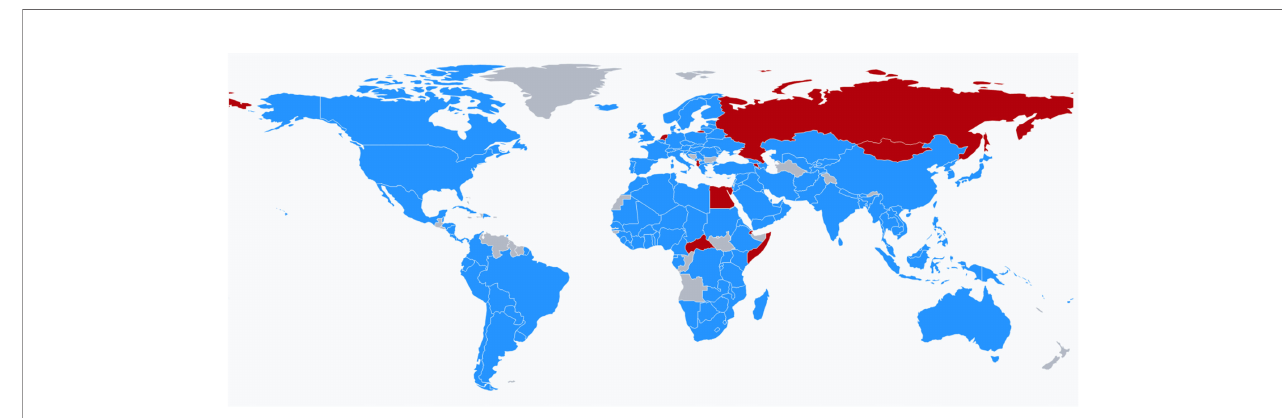
FIGURE 1 | World map showing the countries (in blue) that, during 2020-2021 responded favorably to the question “ Has your National AMR Action Plan development and implementation process been affected by the COVID-19 pandemic and the national response in your country? ” . Countries in red are those who responded negatively. Source: Global database for the Tripartite Antimicrobial Resistance (AMR) Country Self-Assessment Survey (TrACSS) https://